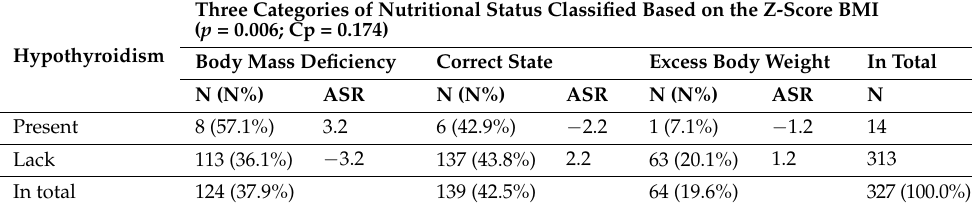
Table 16. Relationship between three categories of nutritional status and accompanying recogni- tion